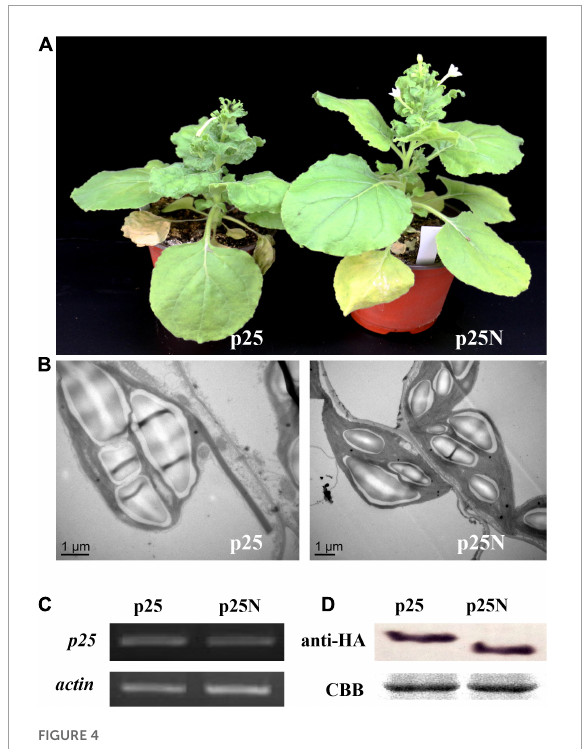
FIGURE4 Pathogenicity analysis of the nuclear localization signal (NLS) in p25 using Nicotiana benthamiana plants. p25, plants inoculated with hybrid virus TMV-p25; p25N, plants inoculated with hybrid virus TMV-p25N lacking NLS. (A) Phenotype of plants inoculated with either the hybrid virus TMV-p25 or TMV-p25N. (B) Transmission electron micrographs of infected leaves. Scale bars: 1 µ m. (C) Transcripts were detected by RT-PCR using extracted leaf RNA that was reverse transcribed. The actin of N. benthamiana was used as the internal control. (D) Western blot of p25 using an anti-HA antibody. Coomassie brilliant blue-stained Rubisco protein (blue bands) is shown as a total protein loading